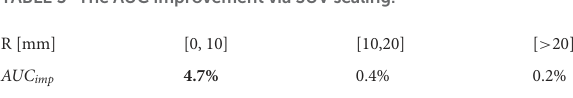
TABLE 3 The AUC improvement via SUV